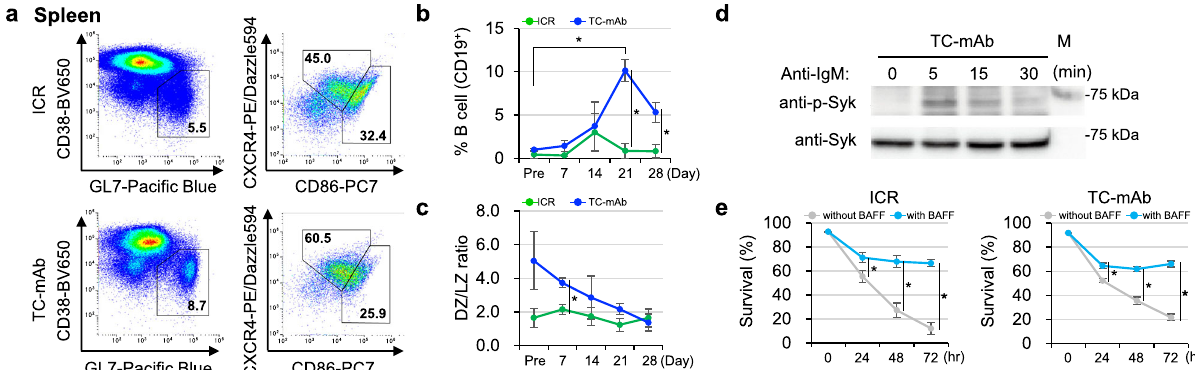
Fig. 8 Analysis of spleen cells in immune system stimulation. a Flow cytometry of germinal centre B cells (CD19 + CD38 lo/- GL7 + ) (left) and dark (CD19 + CD38 lo/- GL7 + CXCR4 hi CD86 lo ) and light zone (CD19 + CD38 lo/- GL7 + CXCR4 lo CD86 hi ) (right). The percentage of germinal centre B, dark zone and light zone at day 14 after immunization are represented. Gating strategies are presented in Supplementary Fig. 27. b The percentage of cells in the germinal centre B cells in CD19 + B cells of ICR (green) and TC-mAb (blue) mice. All gating panels of germinal centre B cell subsets are presented in Supplementary Fig. 28. P -values (two-tailed unpaired Student ’ s t test) between ICR and TC-mAb mice of the percentages of germinal centre B subsets were 0.202 (Pre, pre-immune), 0.139 (day 7), 0.790 (day 14), 0.002 (day 21) and 0.013 (day 28). P -values between pre and a peak timepoint of germinal centre B subset percentages were 0.236 (ICR, pre and day 14) and 0.009 (TC-mAb, pre and day 21). c The ratio of dark and right zone. All gating panels of germinal centre B cell subsets are presented in Supplementary Fig. 29. P -values between ICR and TC-mAb mice of the ratio of dark and light zone B subsets were 0.097 (Pre), 0.006 (day 7), 0.345 (day 14), 0.061 (day 21) and 0.626 (day 28). d Phosphorylation status of Syk of B cells. e B cells from ICR and TC-mAb mice were cultured in the absence (grey) or presence (sky blue) of BAFF for 24, 48 or 72 h. Staining with TOPRO3 was analysed by fl ow cytometry and percentages of TOPRO3-negative gated cells (live cells) are shown. Data are presented as means. Error bars indicate the standard deviation of triplicate measurements. Results were pooled from two independent experiments. * P < 0.05 (two-tailed unpaired Student ’ s t test).